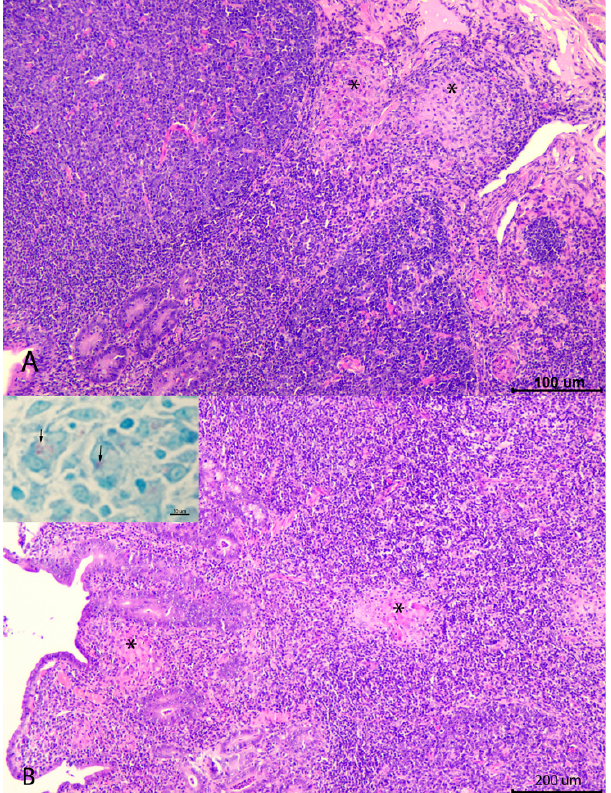
Figure 2. Granulomatous lesions associated with paratuberculosis infection found in the necropsied goats. ( A ): focal lesion, formed by small granulomas (*) located exclusively in the interfollicular area of the Peyer’s patches. Hematoxylin-eosin (HE) ( B ): multifocal lesion, composed of granulomas (*) located both in the interfollicular area on the Peyer’s patches and related lamina propria. HE. Inset: small numbers of acid-fast bacilli (arrows) seen in the lesion located in the lamina propria. Ziehl–Neelsen stain (inset).